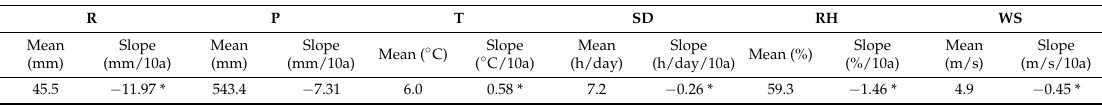
Table 1. The mean value and Mann-Kendall test results of the annual R and climatic elements in the HTRB during 1956–2015.